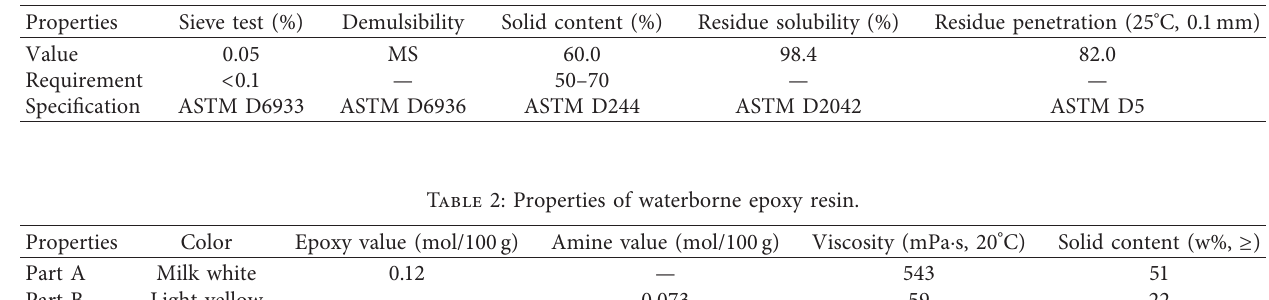
Table 1: Properties of bitumen emulsion.